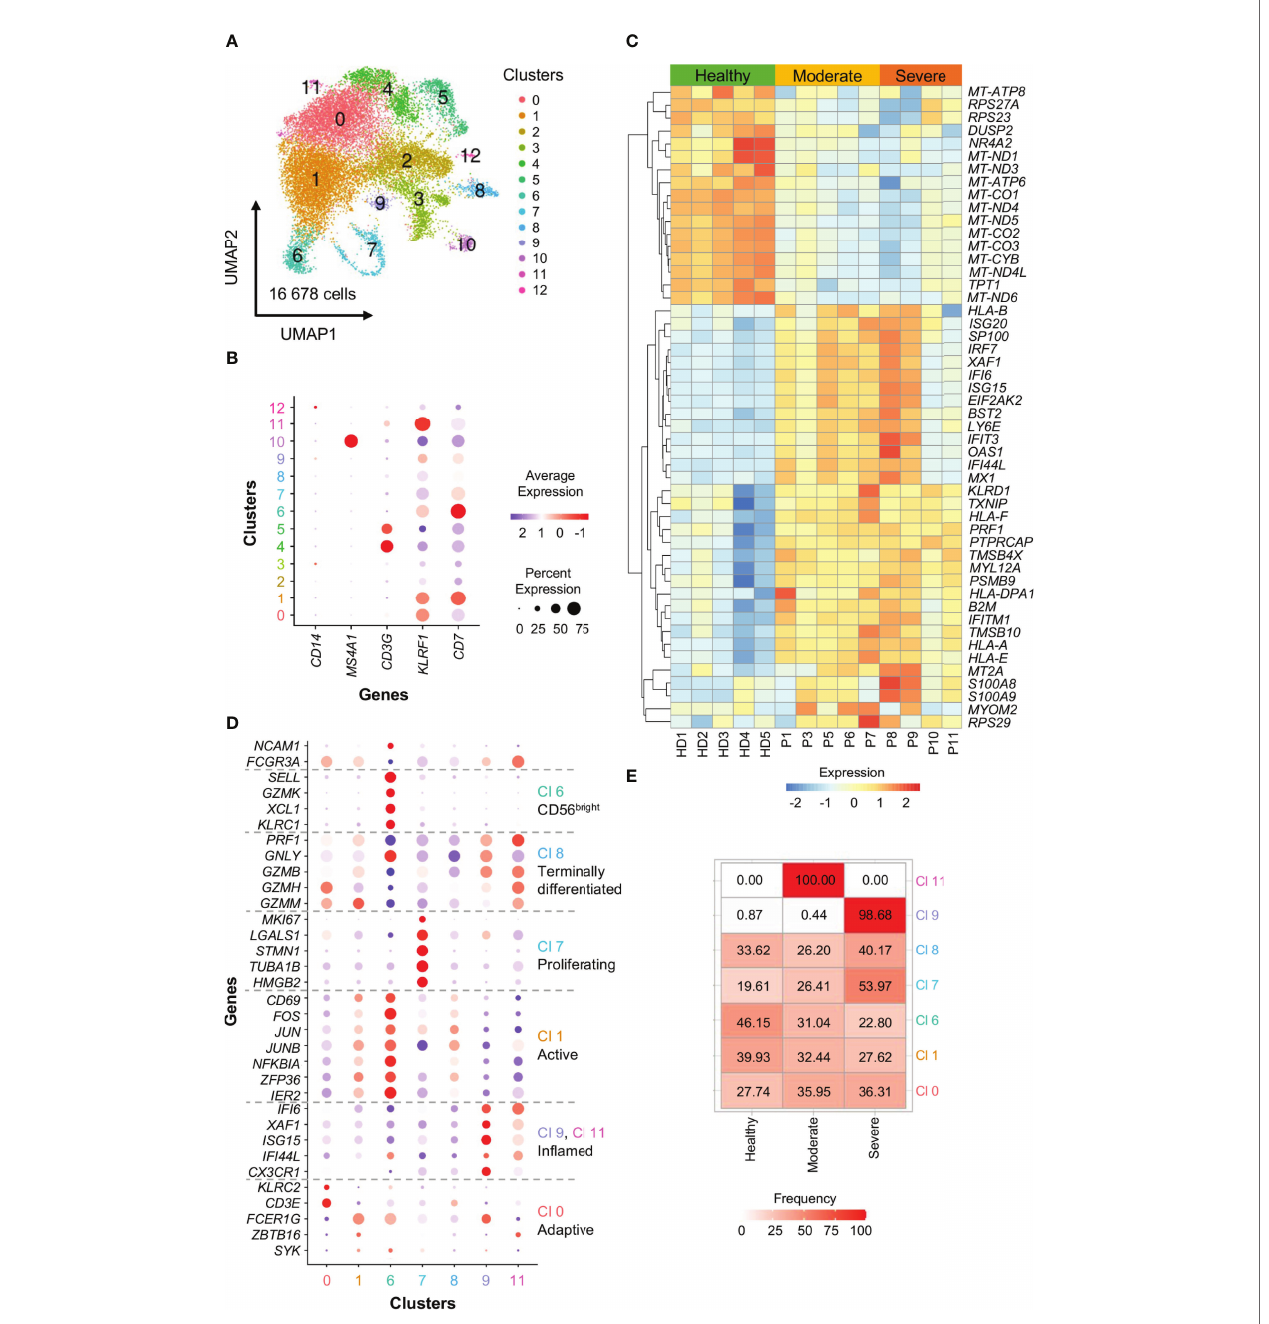
FIGURE 2 | scRNA-seq pro fi ling of NK cells from COVID-19 patients. (A) A total of 16 678 cells were embedded by Uniform Manifold Approximation and Projection (UMAP) plots in 13 clusters at a resolution level of 0.2. Each dot within the UMAP corresponds to one single cell colored according to cell cluster. (B) Ballon plots showing the expression of canonical NK cell markers in the 13 clusters identi fi ed as NK cells. Balloon size corresponds to the frequency of marker-positive cells and balloon color corresponds to the marker expression level of marker-positive cells. (C) Heatmap depicting the top 50 unique DEGs with adj. P value ≤ 0.05. Scale represents normalized counts centered and scaled across cells. (D) Ballon plots showing the expression of 33 NK cell markers to de fi ne cluster (Cl) identities. Balloon size corresponds to the frequency of marker-positive cells and balloon color corresponds to the marker expression level of marker-positive cells. (E) Heatmap showing the distribution of the 7 NK cell clusters among the 3 groups of subjects